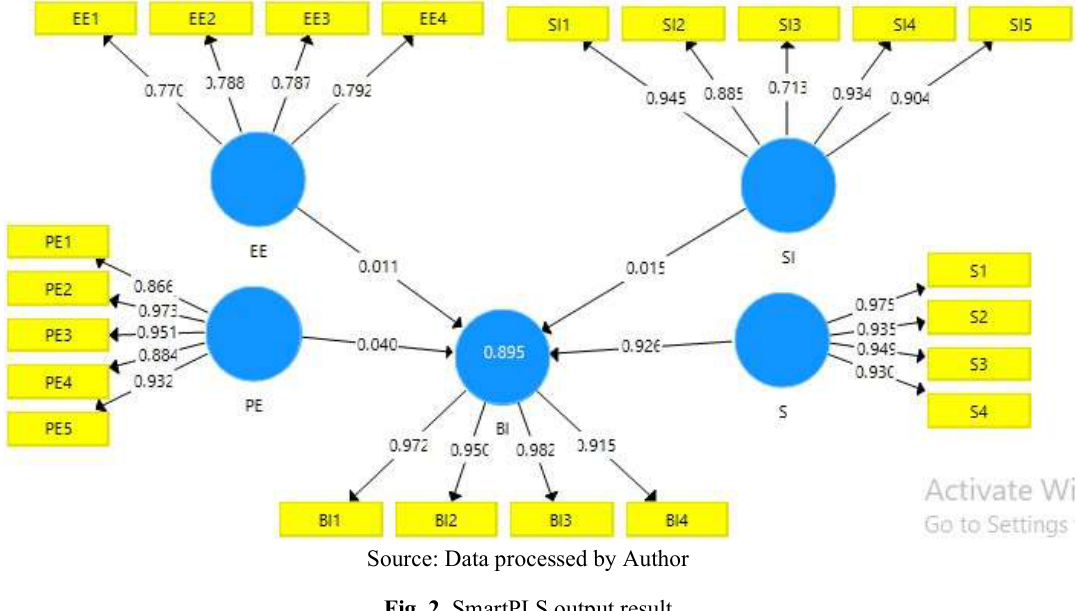
Fig. 2. SmartPLS output result